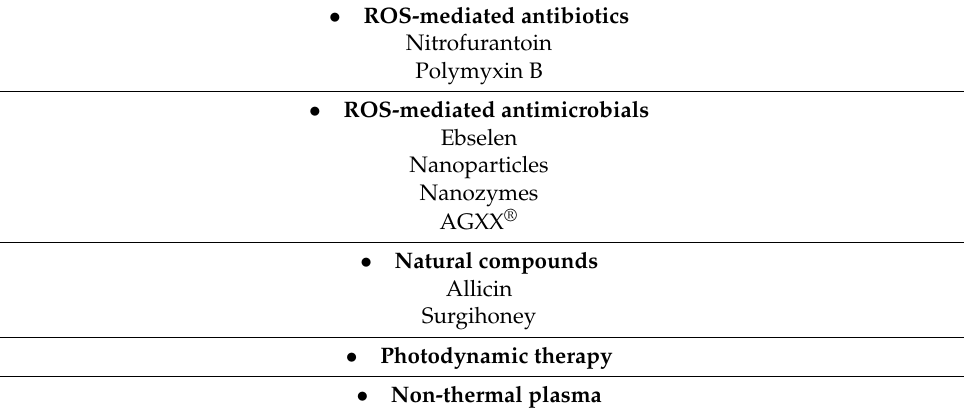
Table 1. List of ROS-mediated alternative antimicrobials/methods generating alternative antimicro-